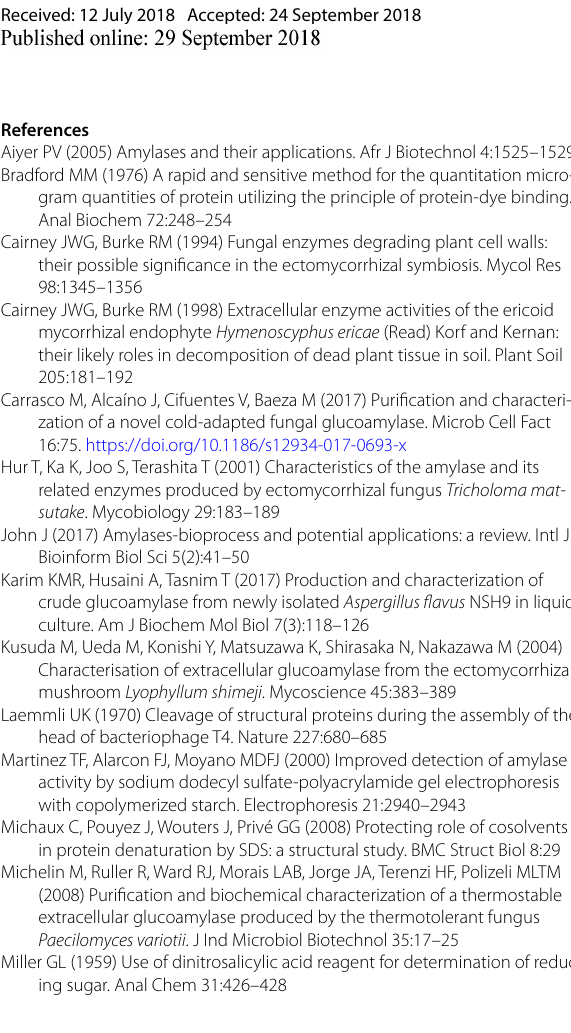
V max and m 2 K m ) = =